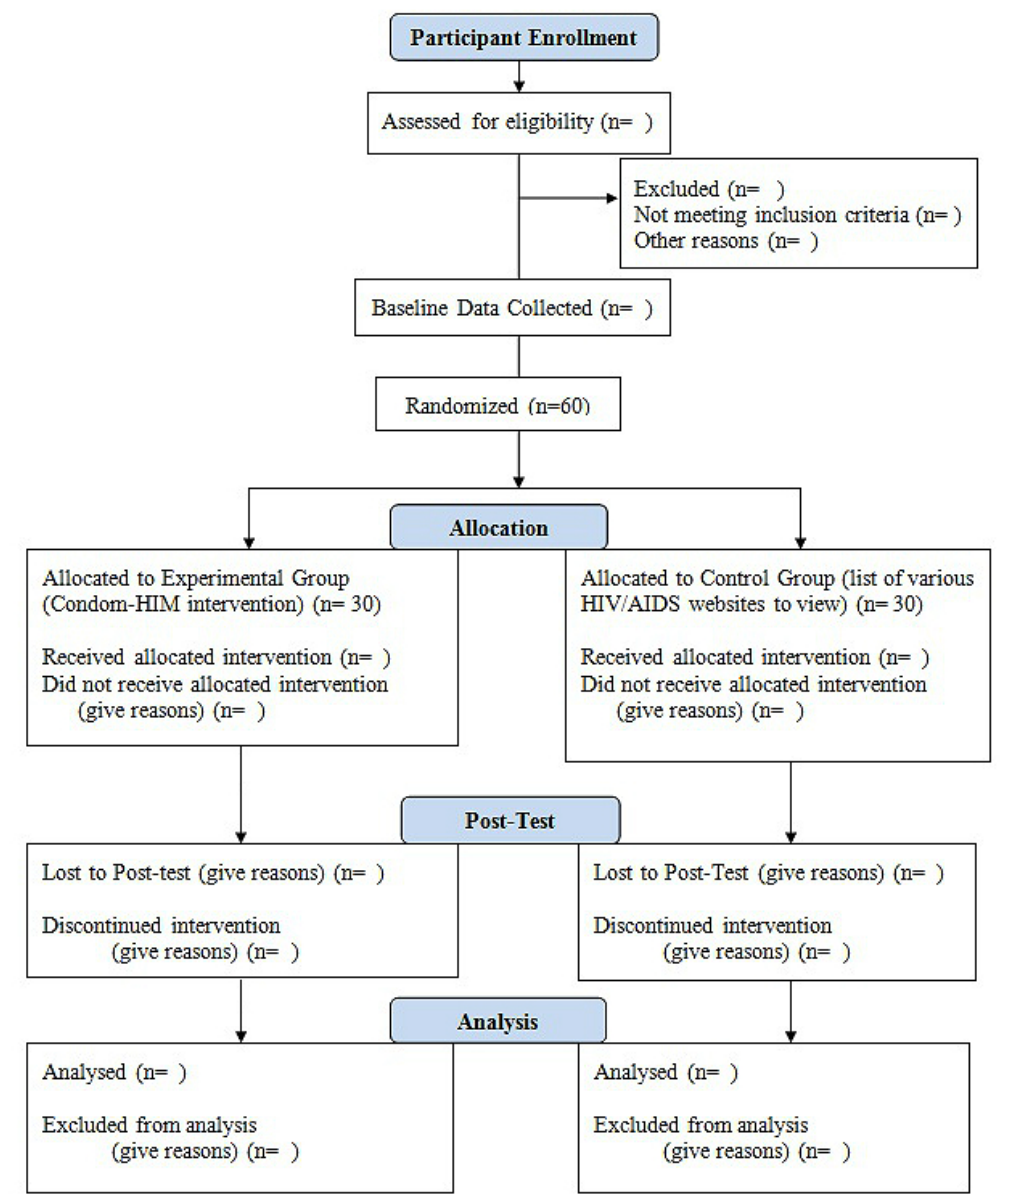
Figure 1. Flow of participants through randomized control trial. As the study is in progress, some n='s are left